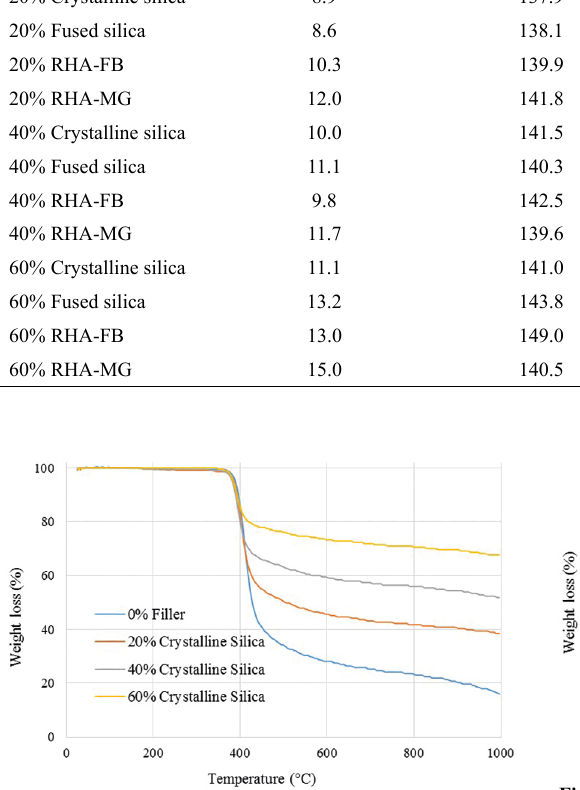
Figure 8. Thermogravimetric analysis of the mixtures prepared with 20, 40, and 60% (wt) crystalline silica